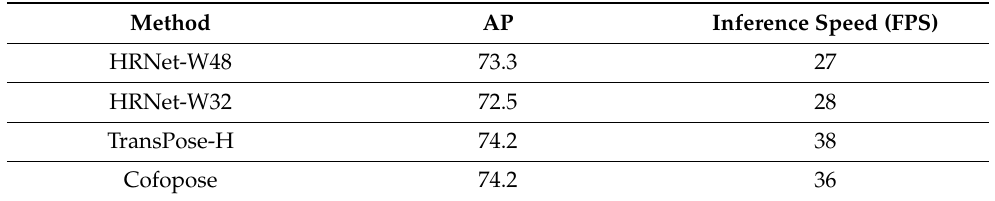
Table 5. AP and inference speed results on COCO val. HRNet and Transpose are trained with 210 and 240 epochs, respectively, whereas Cofopose is trained with 50 epochs. Our network achieves a competitive speed/accuracy